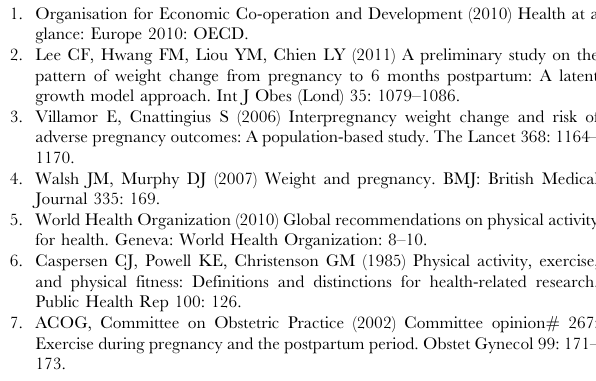
Figure S1 PRISMA 2009 Checklist. PRISMA